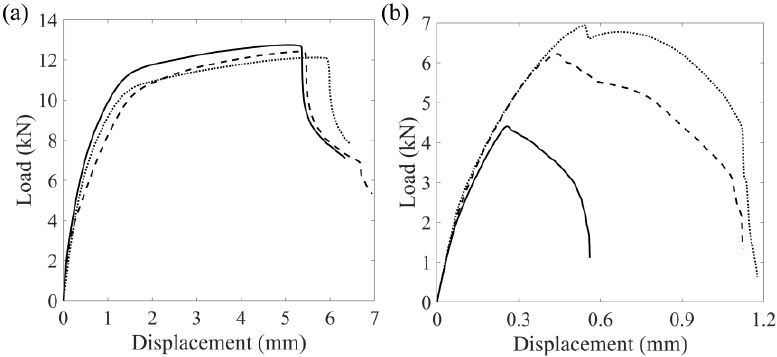
Figure 11. The tensile-shear properties of the welded joints: ( a ) the 1st weld; ( b ) the 704th weld.